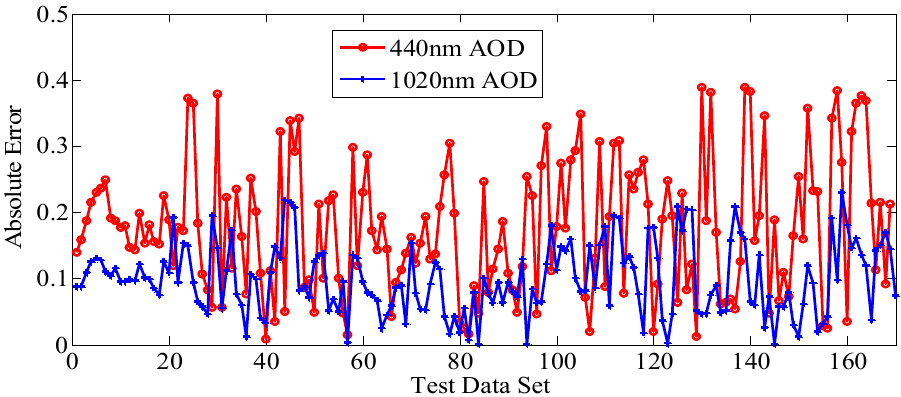
Figure 4. Estimation results of BP neural network model on test data set.